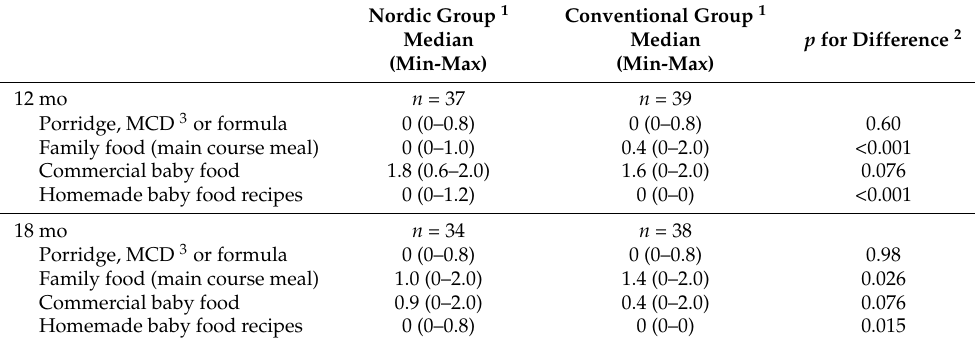
Table 6. Daily type of main course meals at the 12 and 18 mo 5-day dietary